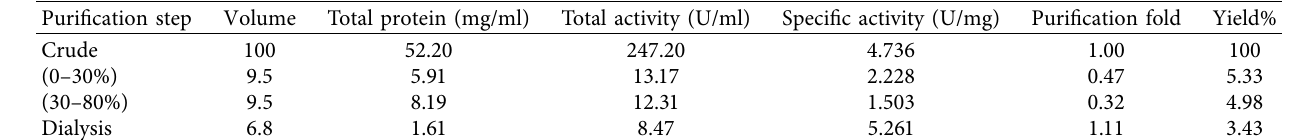
Table 2: Partial purification steps of α -amylase from Bacillus licheniformis .